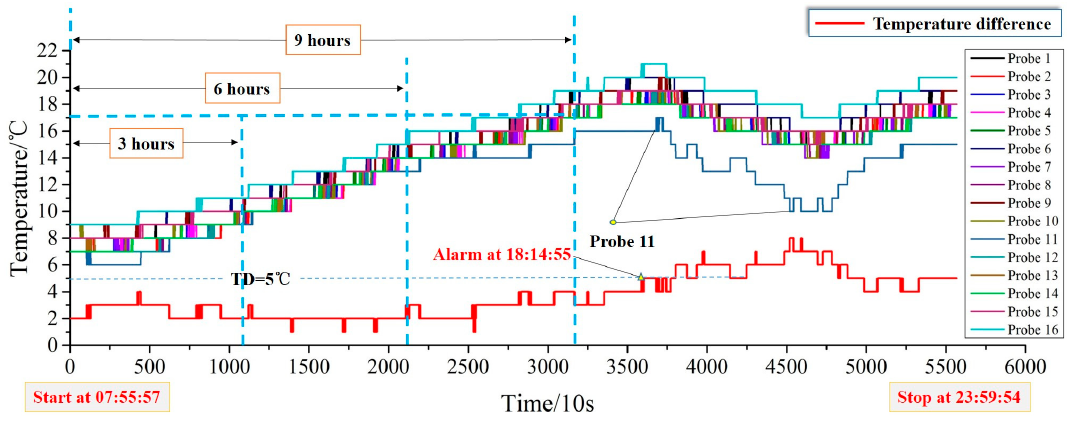
Figure 9. The temperature curves of Vehicle 2.